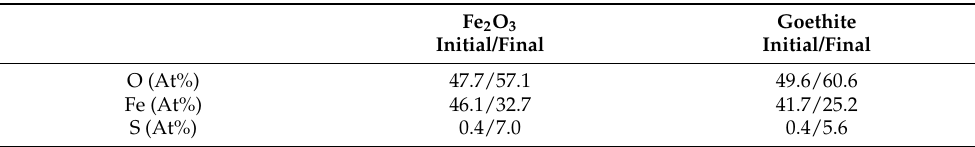
Table 1. EDX composition of the initial and final catalysts.